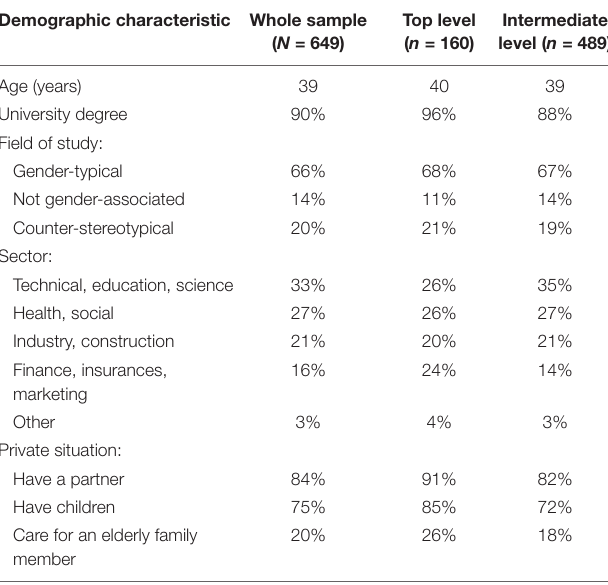
TABLE 1 | Demographic characteristics of the sample of women in leadership